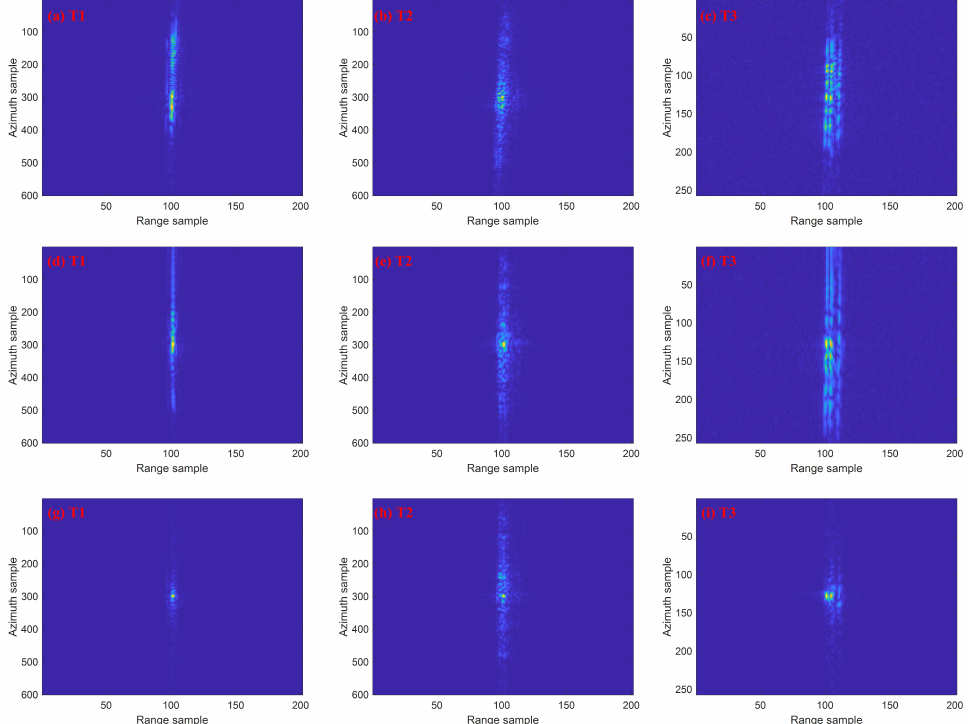
Figure 12. Moving-target focus results. ( a – c ) Magnified images of moving targets without pro- cessing of GMT (defocused). ( d – f ) Refocused results by KT-CICPF. ( g – i ) Refocused results by proposed method.